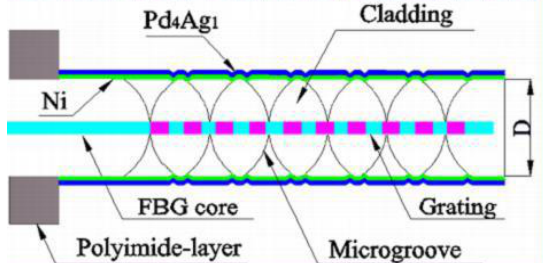
Figure 7. Configuration of double spiral FBG hydrogen sensor [35].